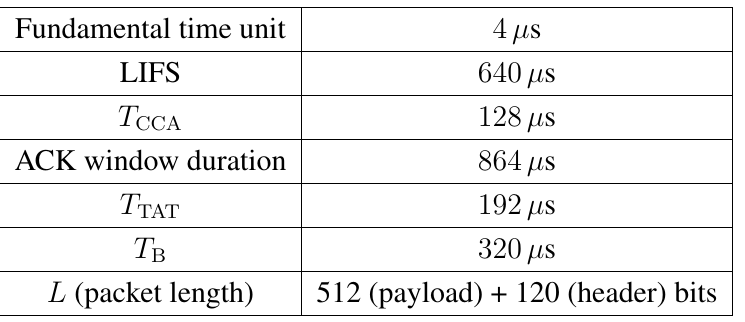
Table 3. Parameters of the Zigbee